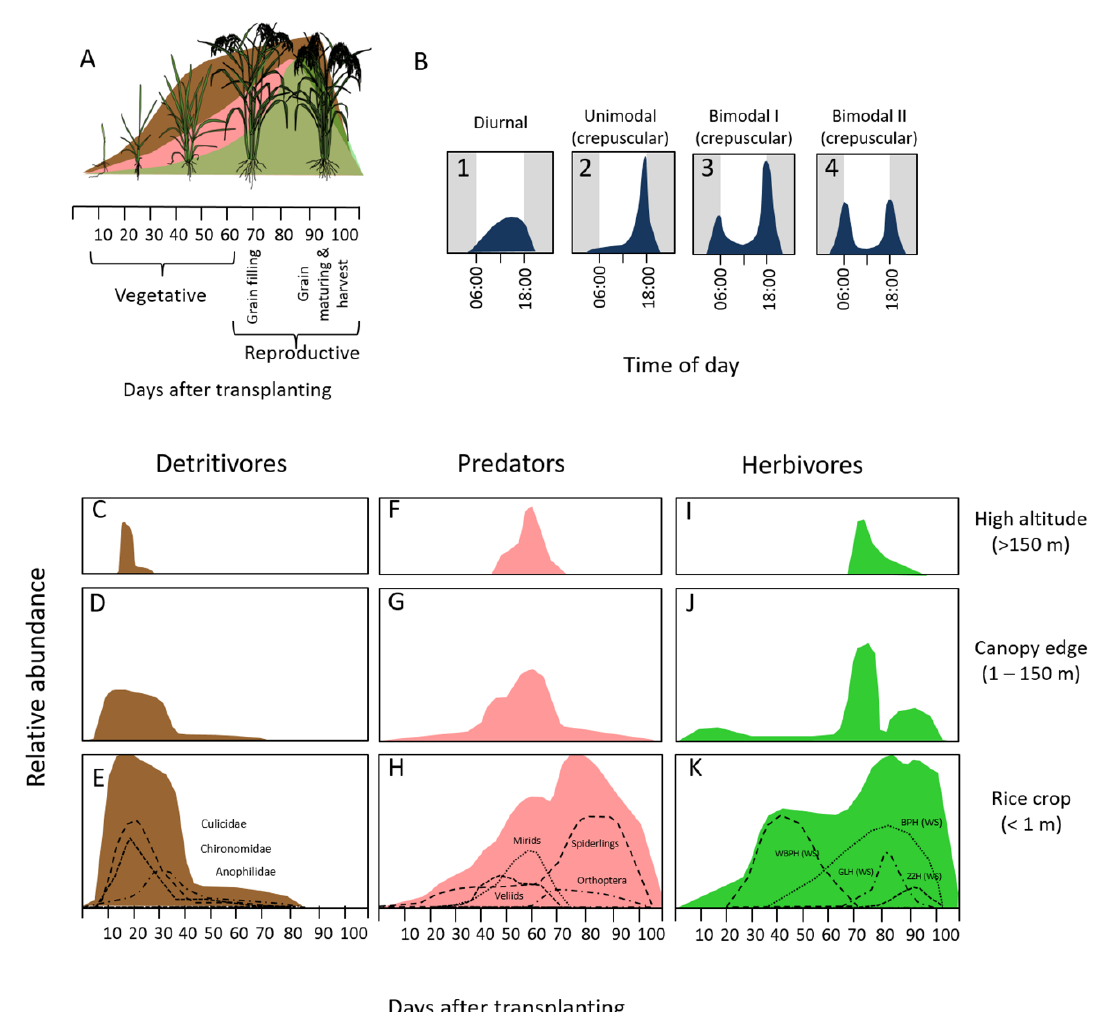
Figure 1. Arthropod activity in and above rice paddies. ( A ) Rice crop stages with indication of accumulated abundance of detritivores (brown), predators (red), and herbivores (green) are redrawn using data from Settle et al. [10] based on field data from Java (Indonesia). ( B ) Patterns of flight activity using data from Perfect and Cook [36] (gray shading = night). Patterns include (1) diurnal flight (e.g., Coccinellidae, Araenae (spiderlings), Hymenoptera and Aphidae [see [37]]); (2) unimodal crepuscular (e.g., Xestocephalus sp.; [36]; (3) bimodal I crepuscular (e.g., S. furcifera , N. lugens , C. bipunctella , N. virescens , R. dorsalis [36]); (4) bimodal II crepuscular (e.g., E. mana [36], Culicidae [47]). Seasonal abundance of detritivores (brown shading: C–E), predators (red: F–H) and herbivores (green: I–J) are indicated for the Luzon, wet-season crop (Philippines). Abundances of key species / groups in the crop are indicated based on published data for [48] [spiderlings], [49] [BPH = brown plant hopper, WBPH = white-backed plant hopper], [50] [Veliids and mirids], [51] [predatory Orthoptera], [52] [Chironomidae), [10] [plankton feeders and detritivores], and [53] [Culicidae] with combined abundances as the crop matures ( E , H , K ). Activity over the crop is indicated using data from Mogi [54] ( D ) and Perfect and Cook [36] ( G , J ), and at higher altitudes from Mogi et al. [55] ( C ) and Riley et al. [56] ( F , I ). Relative abundances of major groups are estimated based on sweep net samples from the International Rice Research Institute (IRRI) (Horgan, unpublished data).